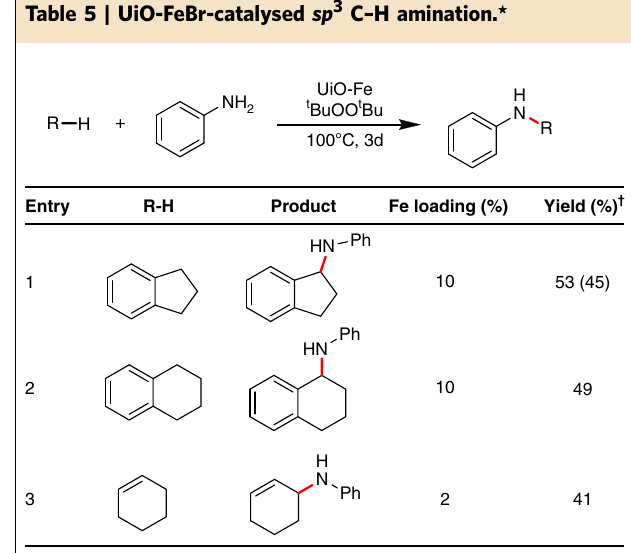
(Supplementary Fig. 9a). EXAFS of UiO-CoCl and UiO-FeBr